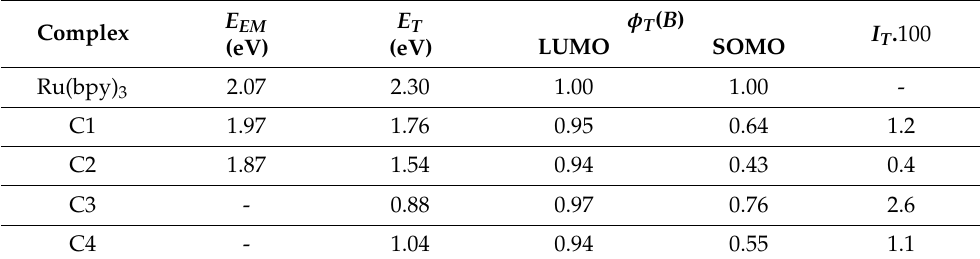
Table 2. Calculated values for the optimized geometry of the triplet state of